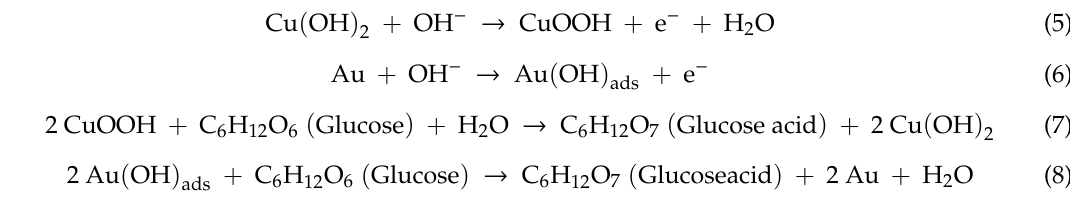
Figure4BdisplaystheLSVcurvesoftheAu@Cu(OH) 2 /